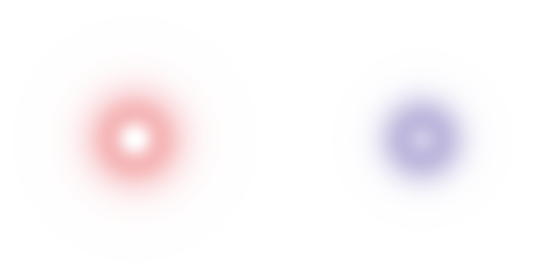
Figure 4: The magnetic field (left) and the energy density (right) of the solutions of (30a) and (30b) for the visible sector, with 𝑞,𝑤 = 1 and 𝛽 = 2 . The darkness of the colors is as in Figure 2.